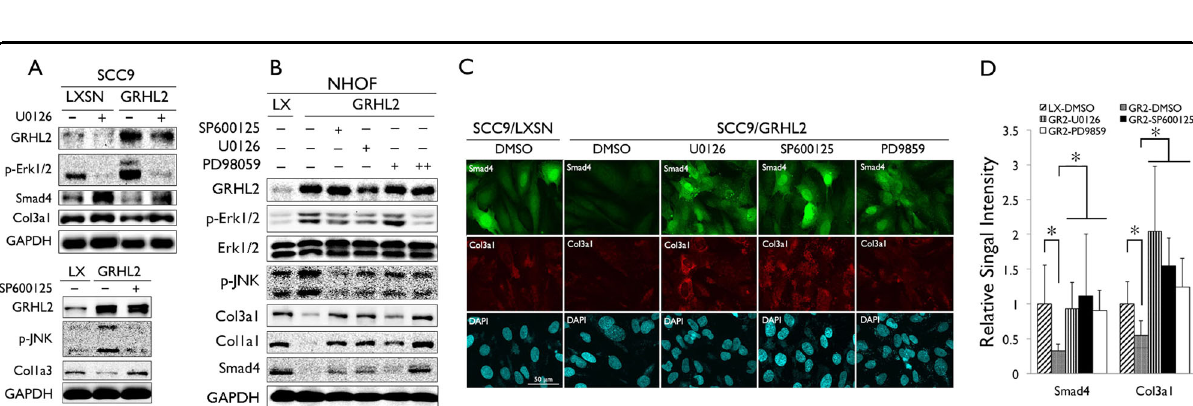
Fig. 7 GRHL2 suppresses TGF- β signaling through activation of Erk and JNK MAP kinases. a SCC9 cells infected with retroviral vector expressing GRHL2 or the empty control vector (LXSN) were exposed to U0126 (10 μ M) for 24 h, and western blotting was performed for GRHL2, p- Erk1/2, Smad4, and C3a1 (upper panels). SCC9/GRHL2 cells were exposed to SP600125 (20 μ M) and western blotting was performed for p-JNK and Col1a3 (bottom panels). b NHOF infected with retroviral vector expressing GRHL2 or the empty vector (LXSN) were exposed to MAPK inhibitors, SP600125 (20 μ M), U0126 (10 μ M), or PD98059 (20 and 50 μ M), for 24 h and western blotting was performed for GRHL2, p-Erk1/2, p-JNK, and TGF- β target genes (Col3a1, Col1a1, and Smad4). GAPDH was used as loading control for all western blotting analyses. c IFS was performed for Smad4 and Col3a1 in SCC9/LXSN or SCC9/GRHL2 cells exposed to DMSO (as controls), U0126 (10 μ M), SP600125 (20 μ M), or PD98059 (50 μ M) for 24 h. d IFS signals were quantitated and plotted with the mean values. Bar indicates mean/SD. * P o 0.05, statistical signi fi cance, compared with